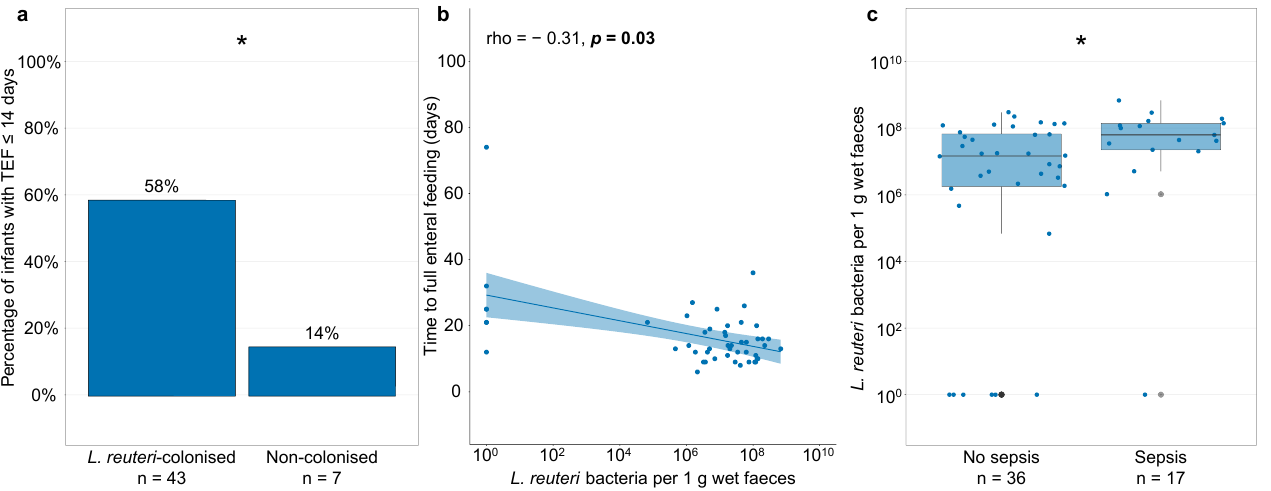
Figure 8. L. reuteri abundance in faeces of the L. reuteri -supplemented group at one week of age and time to full enteral feeding and sepsis. ( a ) Bars show percentage of infants with a time to full enteral feeding (TEF) below or equal to the group’s median of 14 days in infants of the L. reuteri -supplemented group, who had a faecal sample positive ( L. reuteri -colonised) or negative (non-colonised) for L. reuteri at one week of age. ( b ) Spearman correlation between L. reuteri abundance at one week of age and TEF (expressed in days after birth) in L. reuteri -supplemented infants. ( c ) L. reuteri abundance in faeces of L. reuteri -supplemented infants at one week of age who later do or do not develop sepsis. Boxplots show median with 25% and 75% percentiles and 1.5 × the interquartile range. Infants were excluded if information on TEF was missing ( n = 3) or if infants reached full enteral feeding before faecal sampling at one week of age ( n = 3) ( a , b ). For one infant who did not reach full enteral feeding by PMW 36, for graphical display, TEF was set to the day on which the infant reached PMW 36 (74 days) ( b ). Three infants were excluded because sepsis occurred before faecal sampling at one week of age ( c ). L. reuteri abundance is shown as the number of L. reuteri bacteria per 1 g wet faeces and, for graphical display, the number of L. reuteri bacteria per 1 g wet faeces was set to 10 0 for infants with L. reuteri -negative faeces ( b , c ). Statistics: Fisher’s exact test ( a ), Mann–Whitney U test ( c ). * p <